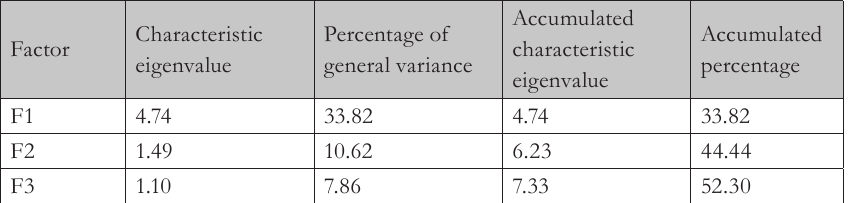
Tab. 1 – Matrix of eigenvalues for factors determining sources of enterprise’s competitive advantage. Source: own